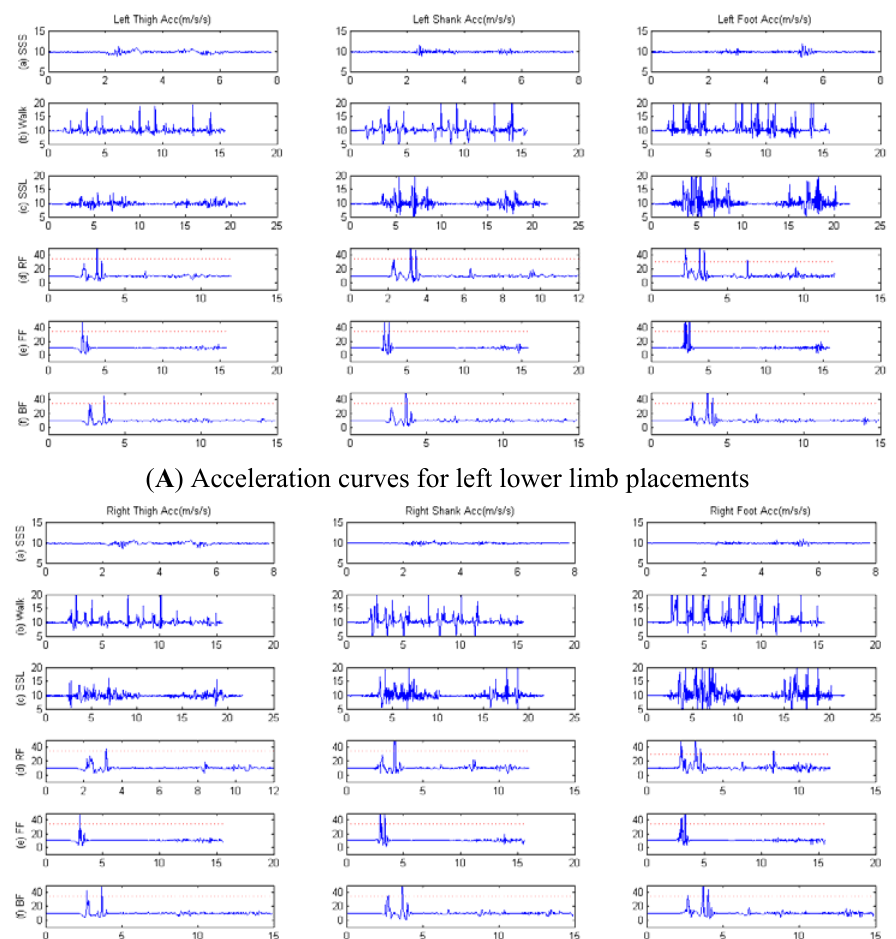
( B ) Acceleration curves for right lower limb